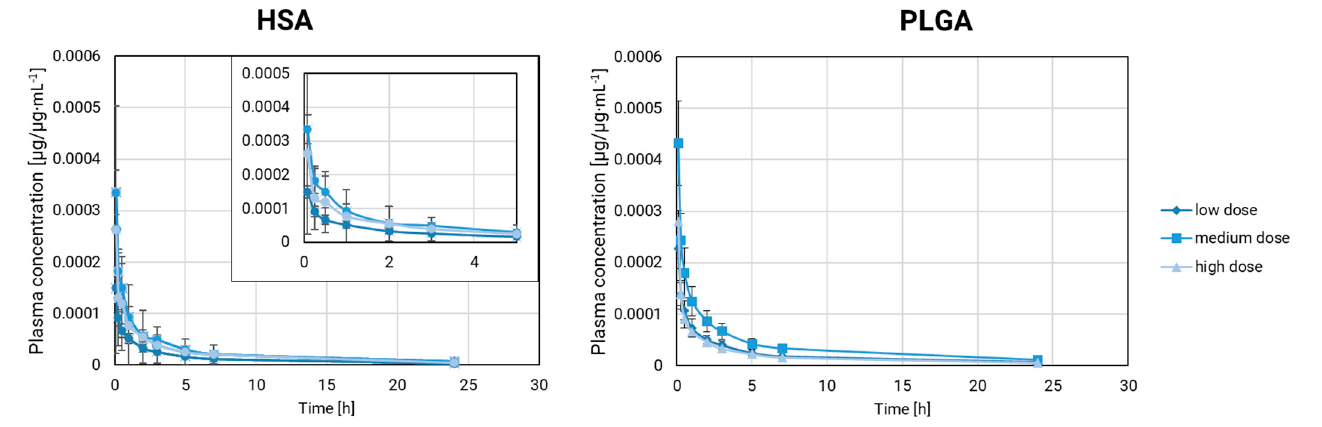
Figure 4. Pharmacokinetics in rabbits: HSA-stabilized rifabutin particles ( n = 5, Mean ± SD) and rifabutin-loaded PLGA nanoparticles ( n = 6, Mean ± SD). The dose fraction µg/µg per milliliter is presented to enable a direct comparison of the three formulations at di ff erent dose levels. The lowest dose strength of HSA-stabilized rifabutin particles is likely corresponding to the behavior of protein- bound monomolecular rifabutin after injection.